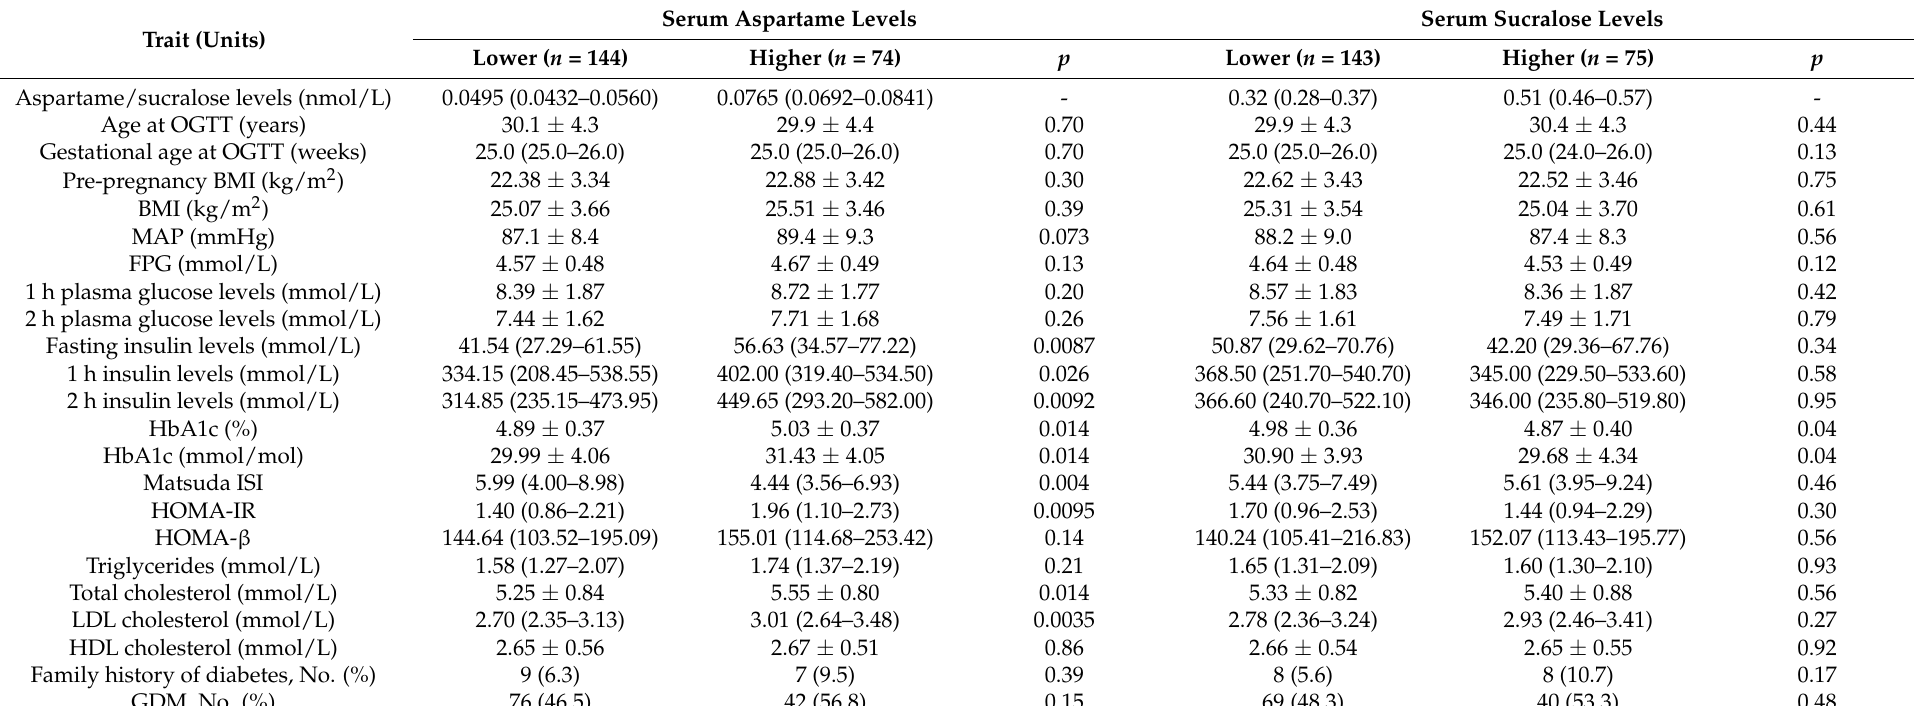
Table 1. Characteristics of participants with higher and lower serum levels of